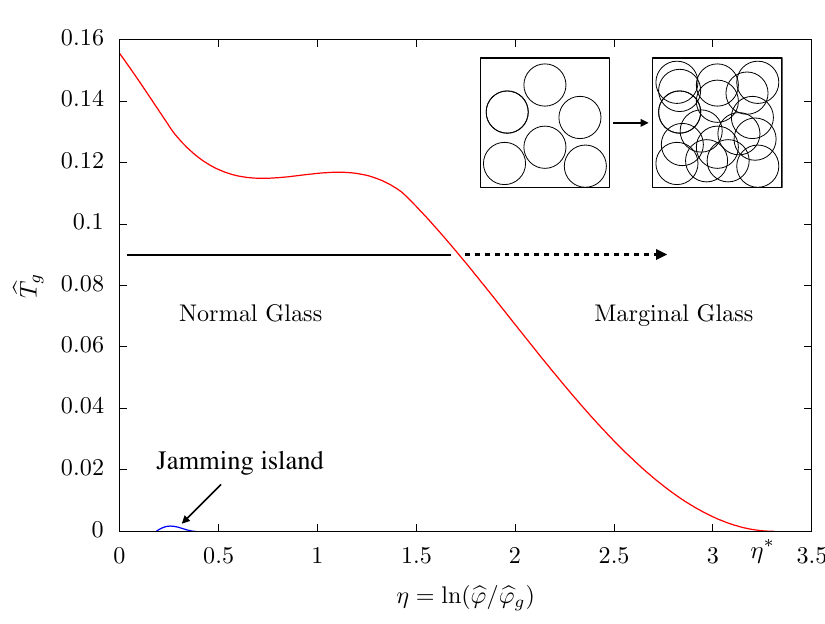
ϕ = 8, ) and then compressed. There (cid:98) T g (cid:98) g